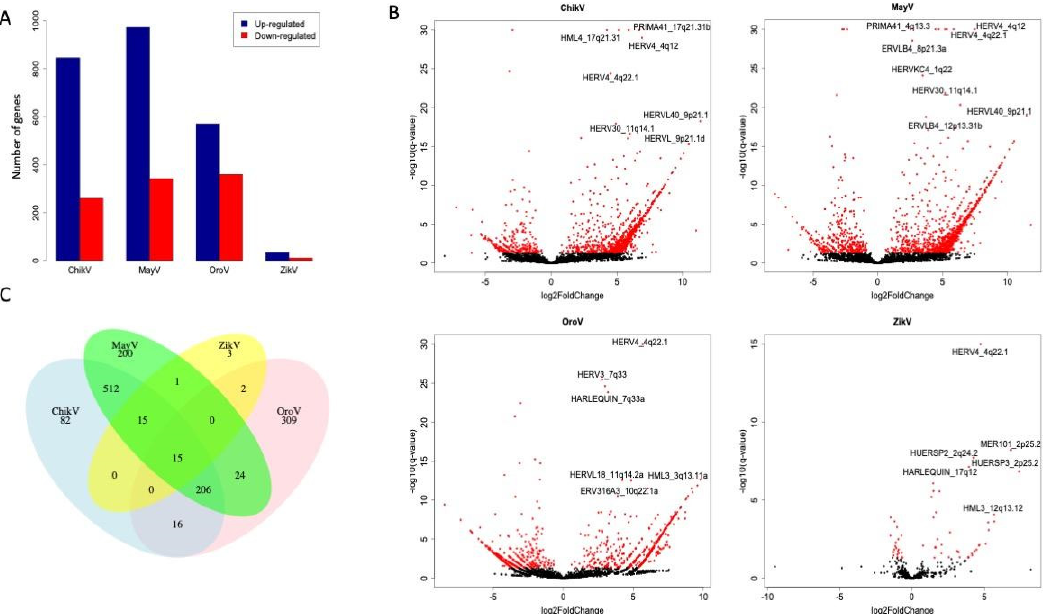
Figure 1. Modulation of HERVs’ expression in human primary astrocytes infected with ChikV, MayV, OroV, and ZikV. ( A ) The number of differentially expressed HERVs comparing the induced (upregulated) and suppressed (downregulated) HERVs by the four viruses. ( B ) Dispersion of the HERVs comparing the log2FC and significance ( − log10(q-value)). The red dots indicate the accepted differentially expressed HERVs up to log2FC > 1 and adjusted p -value < 0.05. ( C ) Specific co-regulation of HERVs by the four viruses ChikV, MayV, OroV, and ZikV. Table 1. Differentially expressed HERVs present in all